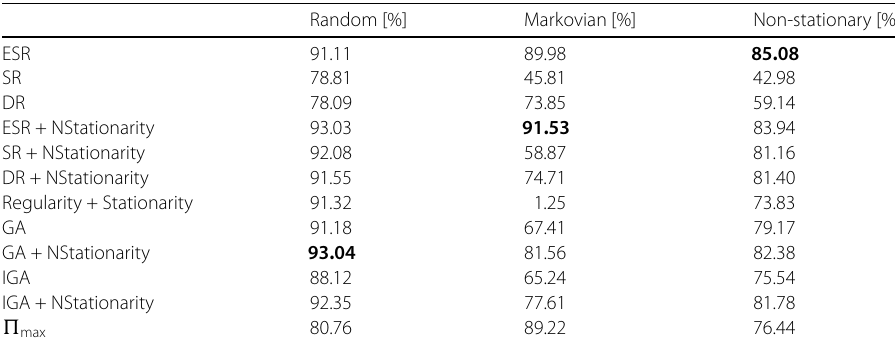
Table 7 An average proportion of variation of accuracy of predictions made on the synthetic sequences explained by the regression models fit to the evaluated metrics Random [%] Markovian [%] Non-stationary [%] ESR 91.11